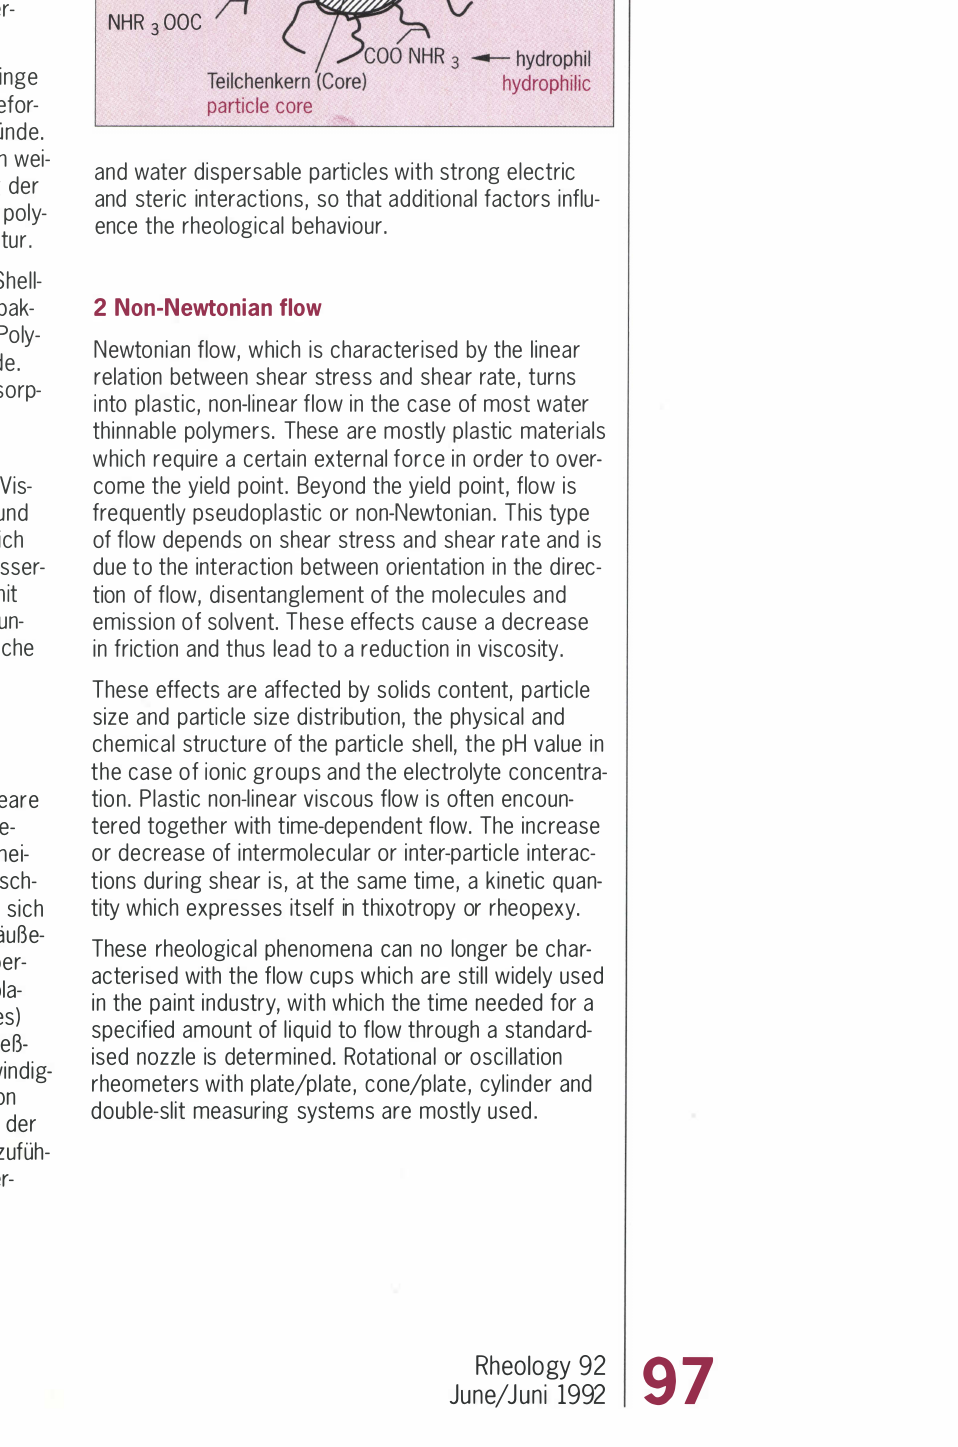
Fig. 2: Schematic diagram of a core shell particle NHR 3 ooc